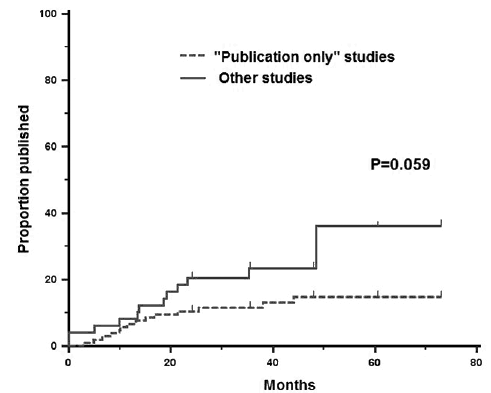
Table 2 - Absolute number and proportion of Brazilian studies in the period